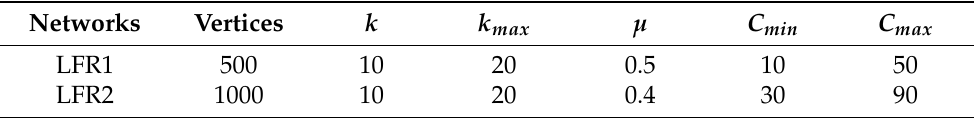
Table 2. Parameter setting of two LFR